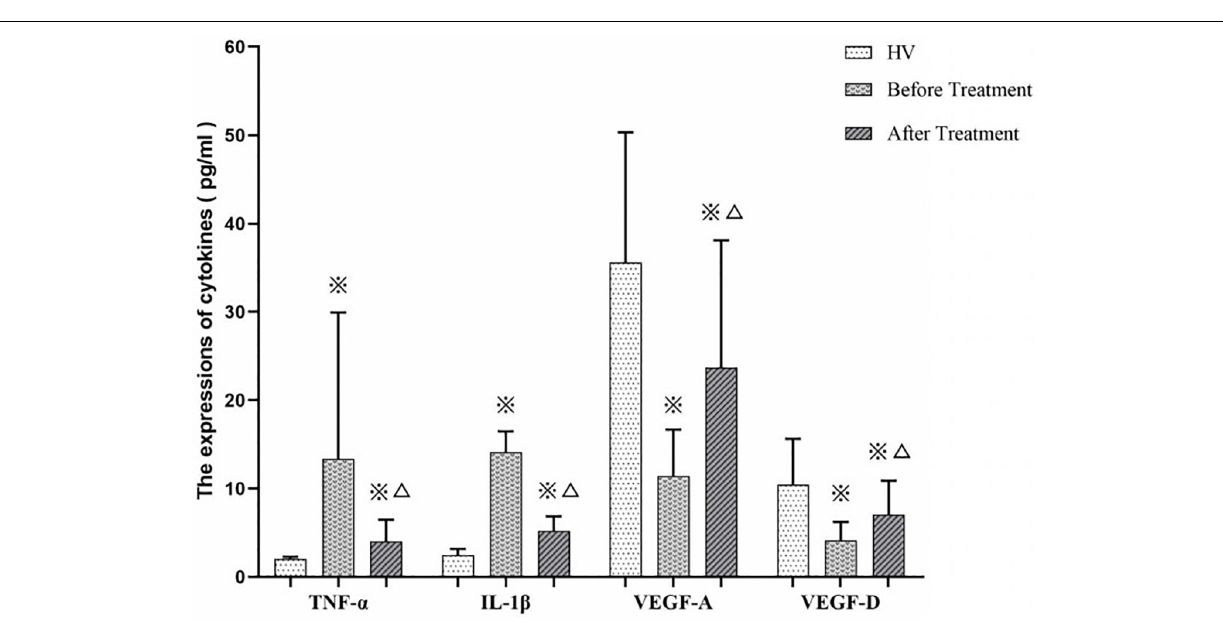
The VEGF signalling pathway is mainly associated with angiogenesis. Vascular endothelial growth factors (VEGFs) constitute a sub-family of growth factors that stimulate the